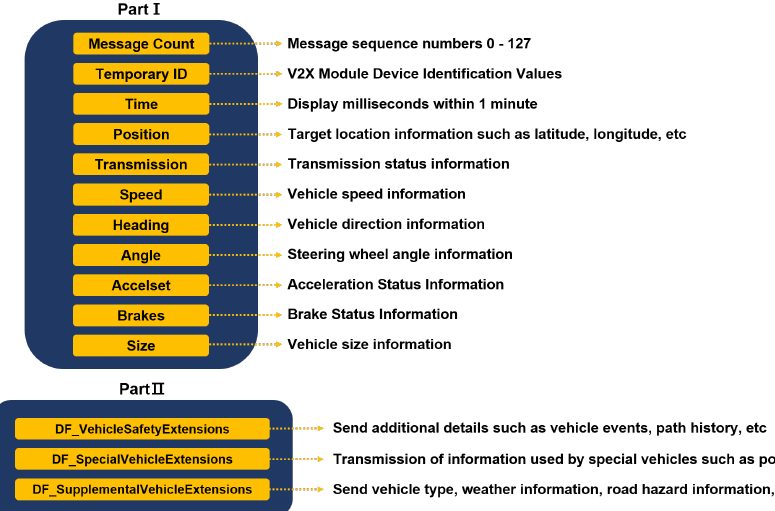
Figure 4. Structure of the BSM message Part I; Part II defined by SAE J2735.